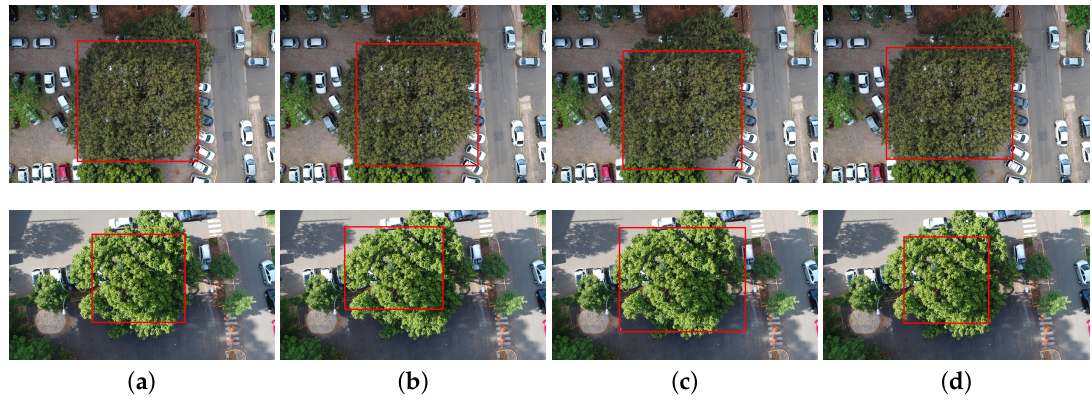
Figure 4. Examples of detection results in images captured in different seasons: ( a ) ground truth; ( b ) Faster-RCNN; ( c ) YOLOv3; and ( d )